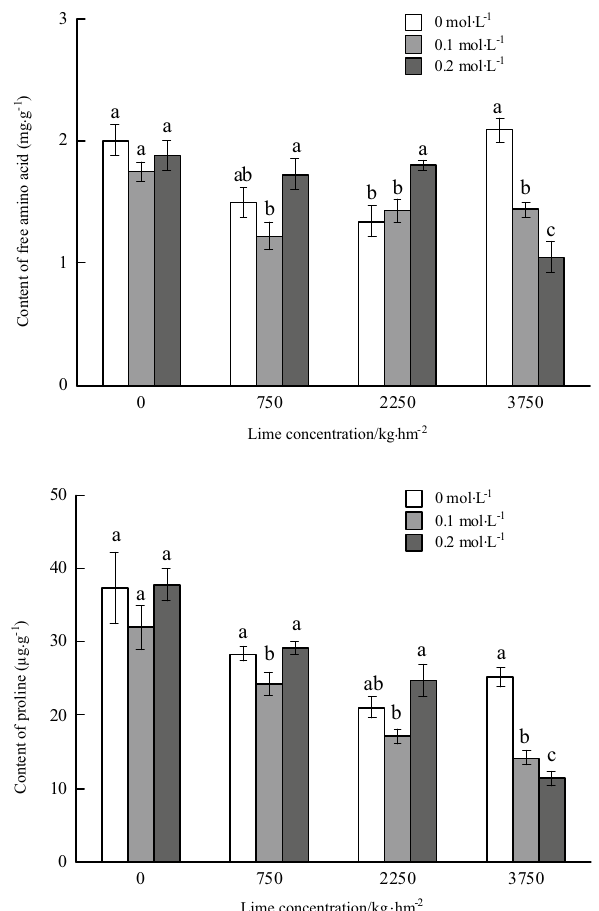
Figure 4. Effects of foliar spraying of oxalic acid on contents of free amino acid and proline in the roots of Panax notoginseng under Cd stress.